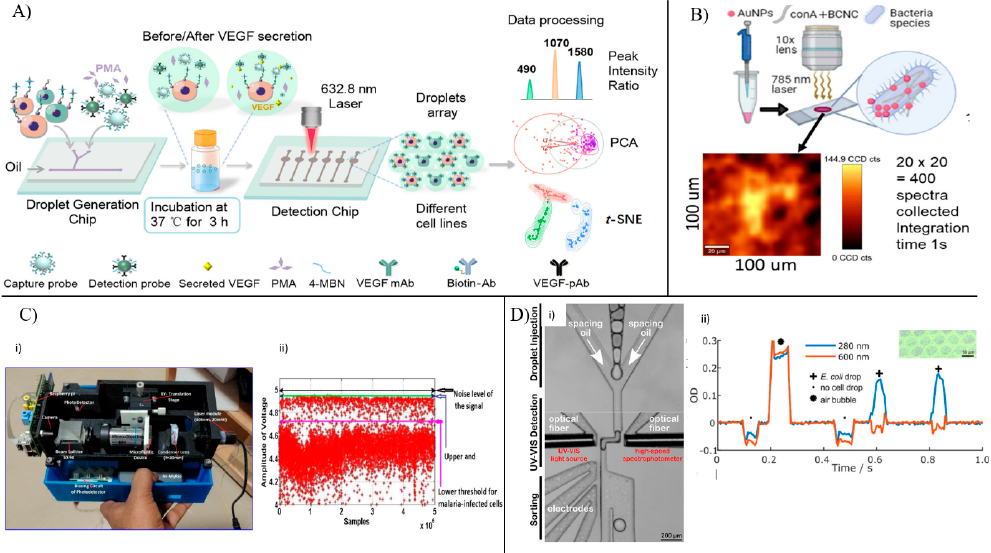
Figure 6. SERS–based sensing platforms for ( A ) secretion of VEGF at single cell level and data